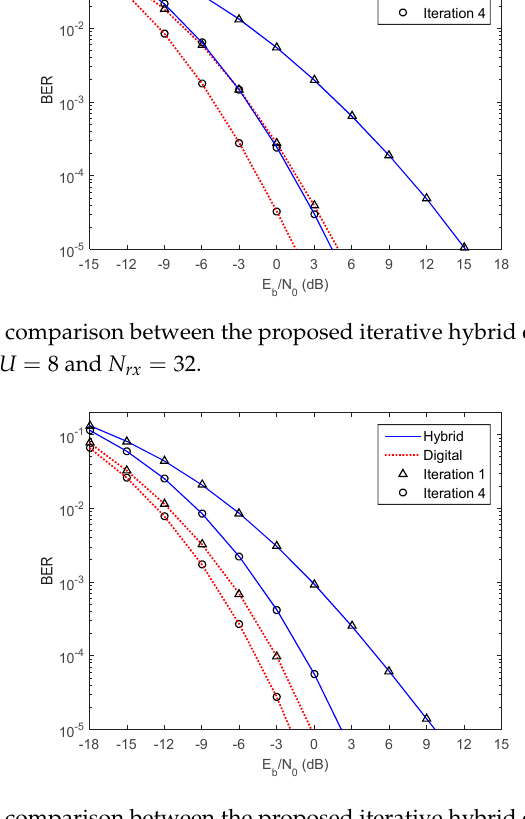
Figure 6. Performance comparison between the proposed iterative hybrid equalizer and full-digital equalizer, with N RF rx = U = 8 and N rx = 64